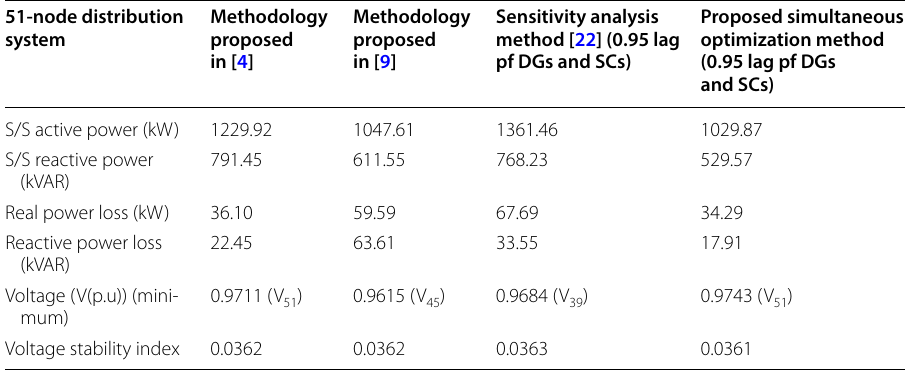
Table 7 Performance comparison for 51-node distribution system